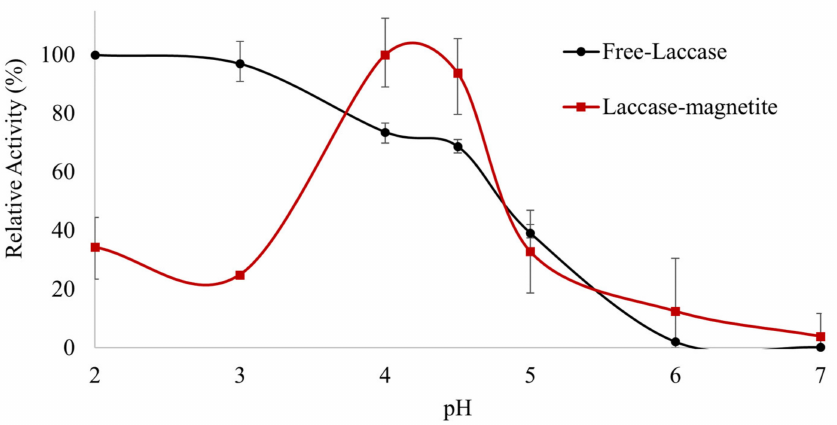
Figure 3. pH profile of free and immobilized laccase on magnetite nanoparticles